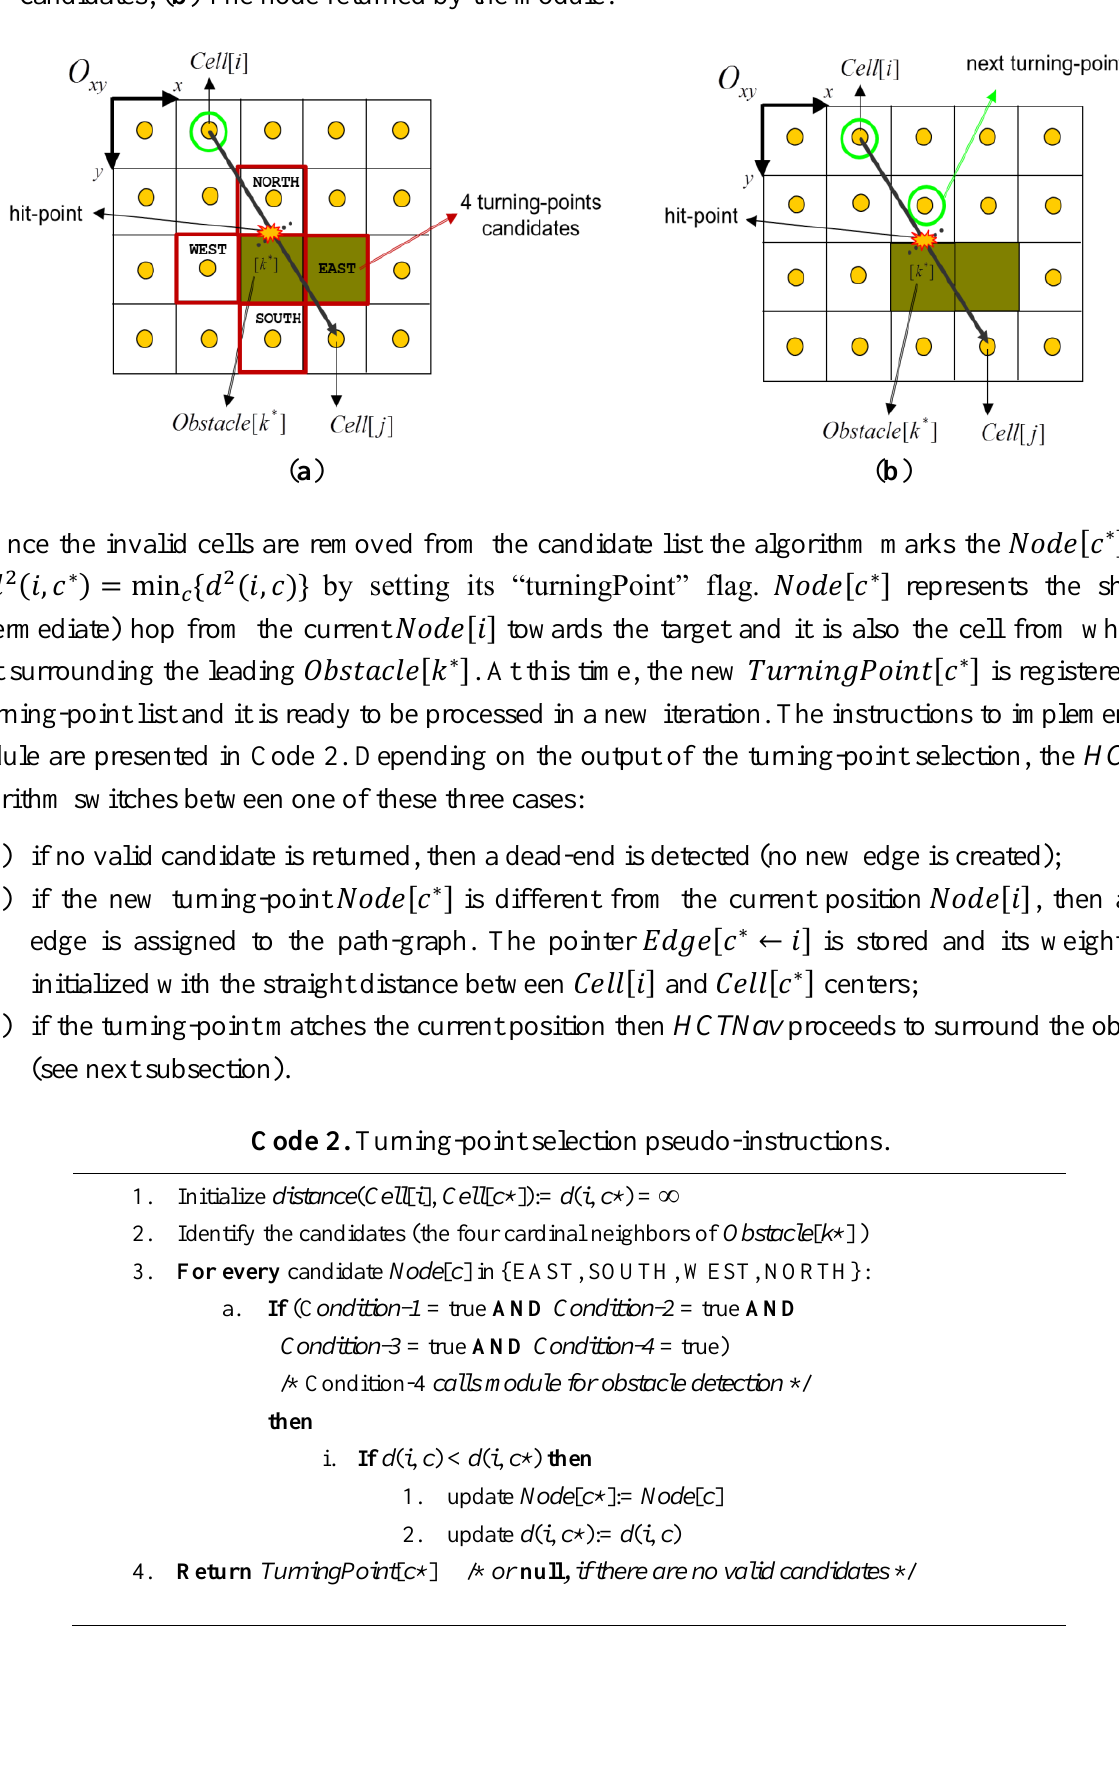
Figure 5. Selection scheme for the next turning-point: ( a ) The four possible cardinal candidates; ( b ) The node returned by the